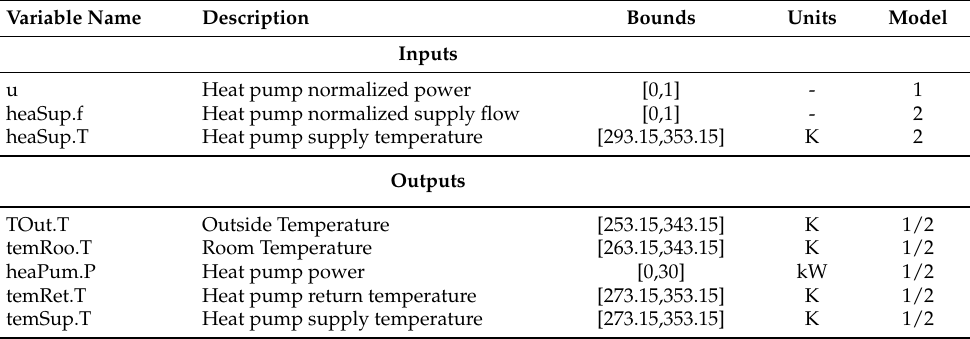
Table A6. Inputs and outputs for the models SimpleHouseRad-v0 and SimpleHouseSlab-v0 (1), and SwissHouseRad-v0 (2).